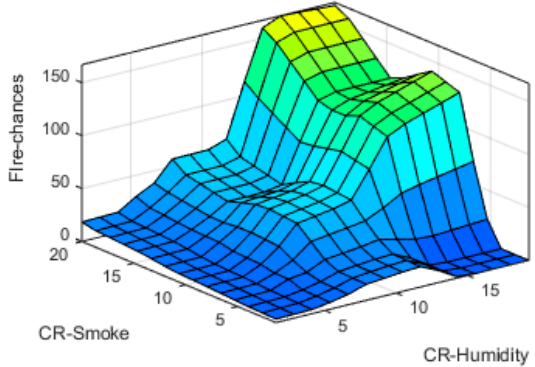
Figure 22. CR-smoke vs. CR-Humidity surface Plot.